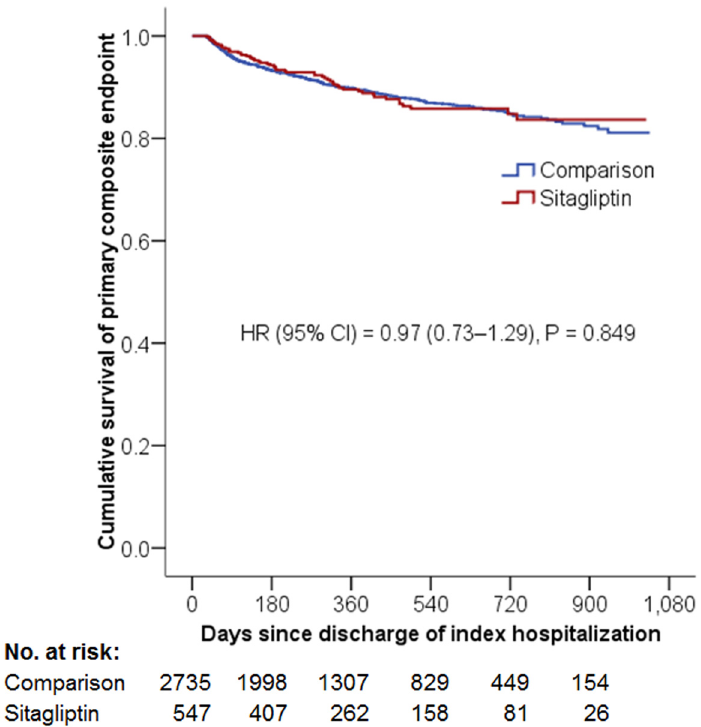
Fig 2. Cumulative Kaplan-Meier survival estimates of the time to primary composite endpoint. The primary endpoint was a composite of myocardial infarction, ischemic stroke, and cardiovascular deatFTh. No significant differences in the primary composite outcomes were observed between the two study groups after a mean follow-up of 14 months.